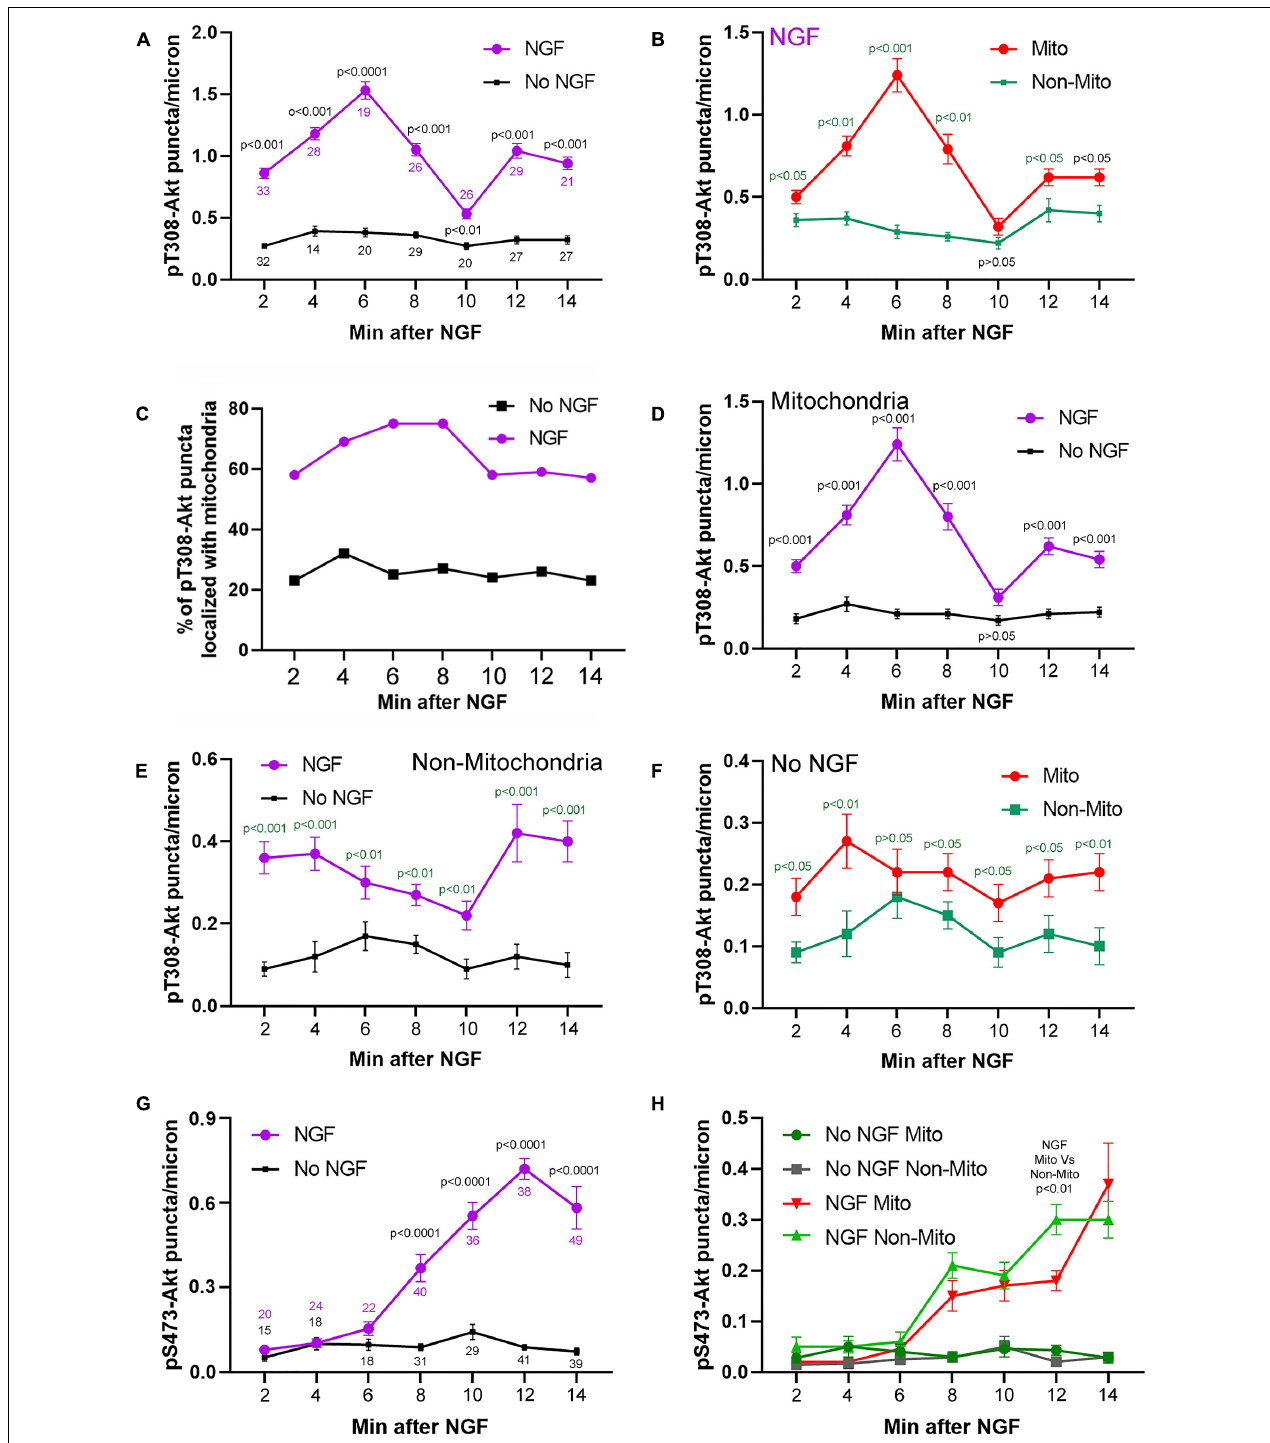
FIGURE 3 | Time course and relationship of pT308-Akt and pS473-Akt to mitochondria positioning during the early phase (2–14 min) of NGF treatment. (A) Levels of pT308-Akt along the distal 50 mm of axon as a function of time after treatment with NGF or vehicle (no NGF). Throughout the figure data are expressed as the number of puncta/micron. Sample sizes ( n = number of axons) at each time point are shown color coded for the respective group. (B–F) Provide further analysis of this data set. (B) Density of pT308-Akt puncta after treatment with NGF in axon segments populated by mitochondria (Mito) and those not containing mitochondria (Non-Mito). These data are extracted from the NGF treatment group in (A) . (C) Percent of pT308-Akt puncta that localized with mitochondria as a function of time